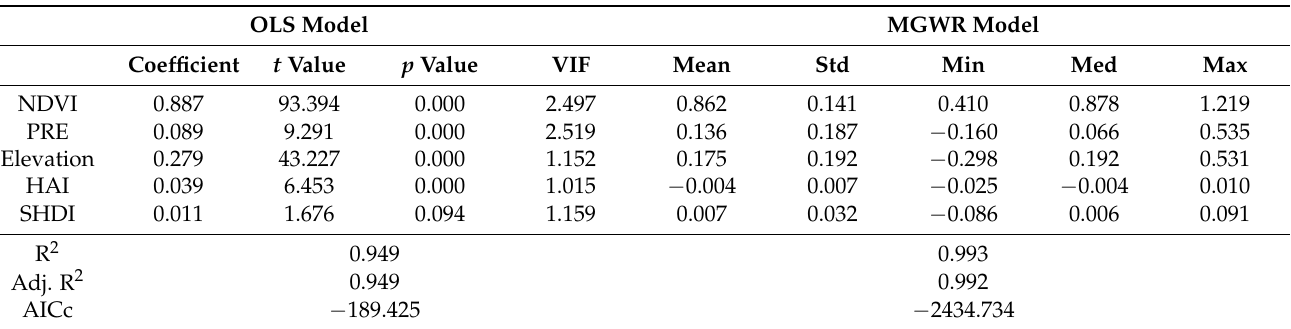
Table 10. Comparison of estimation results between OLS (Ordinary Least Squares) and MGWR (Multiscale Geographically Weighted Regression)